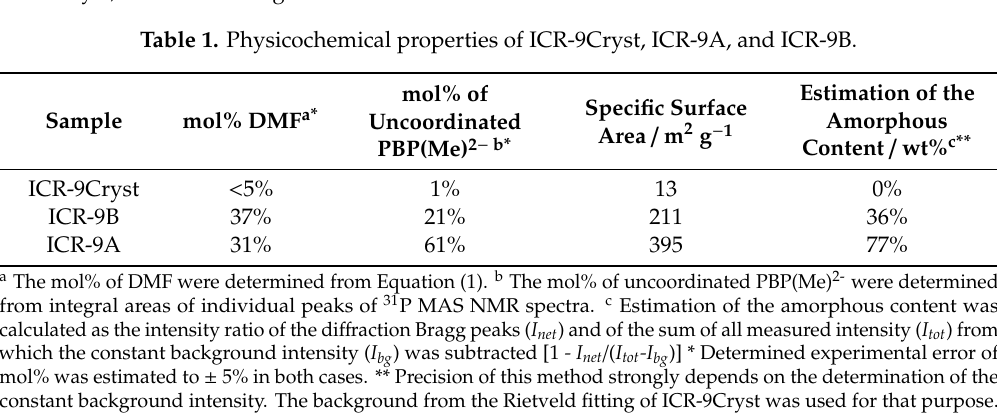
Figure 4. Nitrogen adsorption isotherms for ICR-9Cryst (black), ICR-9B (blue), and ICR-9A (red) at 77 K; adsorption is marked with full symbols and desorption with empty symbols.